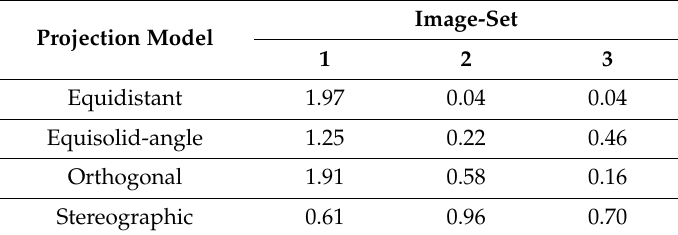
Table 21. Absolute error of focal length (pixel).